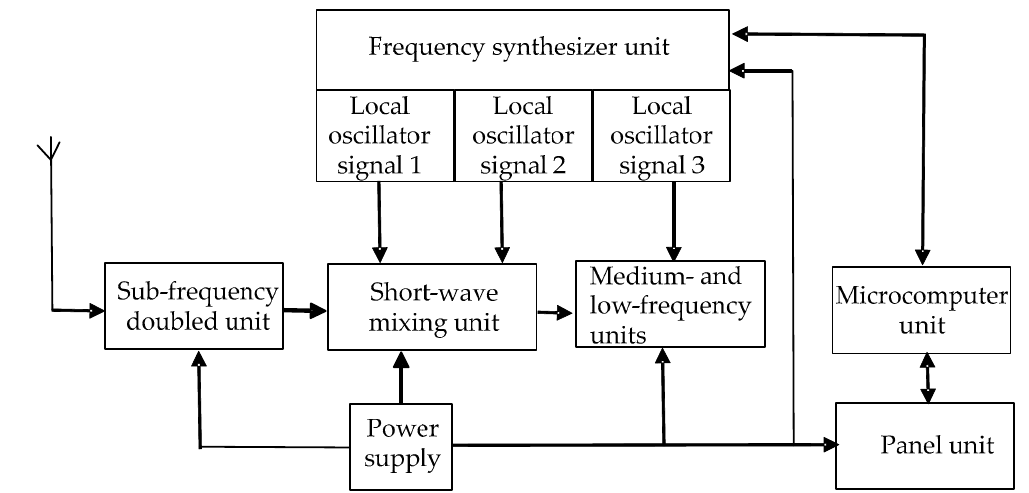
Figure 4. Block diagram of principle of the super heterodyne receiver.